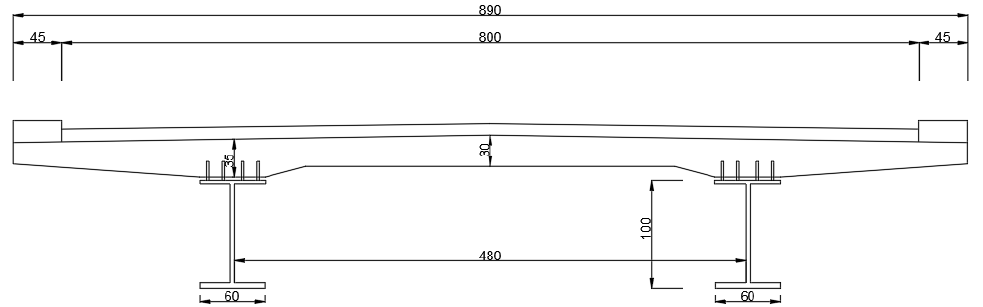
Figure 2. Typical bridge cross-section /cm.